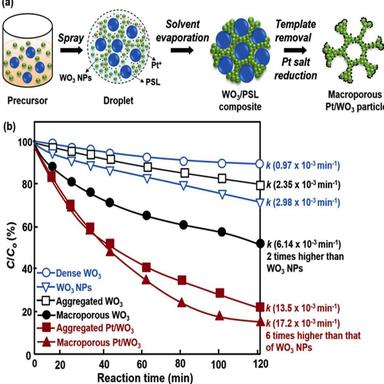
(a) Formation of spherical macroporous Pt/WO3 particles and (b) photodegradation profiles of RhB in the presence of various WO3-based catalysts. Reprinted (adapted) with permission from (ACS Appl. Mater. Interfaces 2015; 7; 3009–3017). Copyright © 2013, American Chemical Society (.